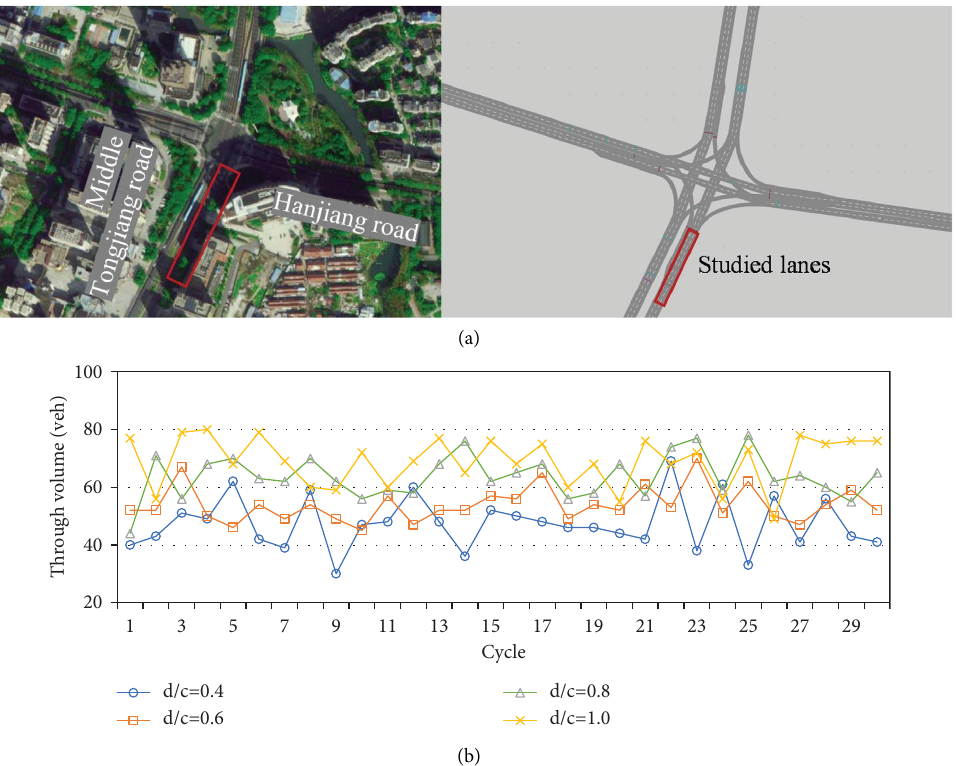
Figure 8: Study lanes for simulation cases. (a) Studied intersection in simulation. (b) Trough volumes of